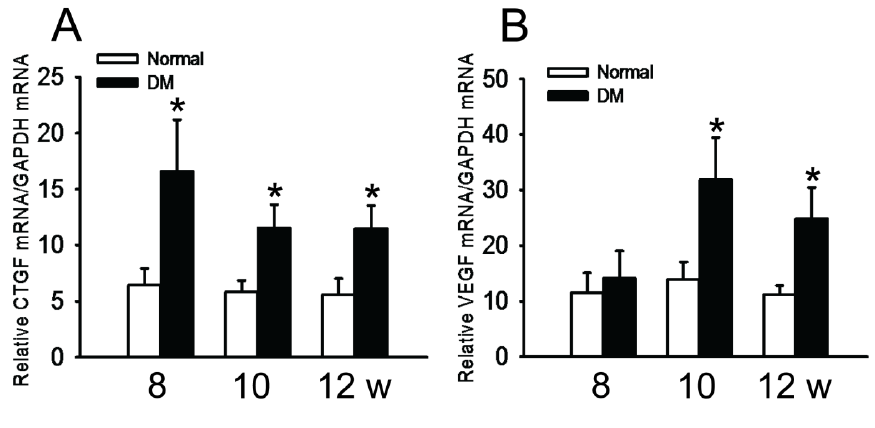
Figure 3. Dynamic changes of CTGF and VEGF gene expression in retina of diabetic rats. ( A ) Relative CTGF mRNA levels in diabetic retinas and normal controls; ( B ) Relative VEGF mRNA levels in the retina of diabetic rats and normal controls. The data represent mean ± SE, n = 6, * p <0.05, Normal vs.